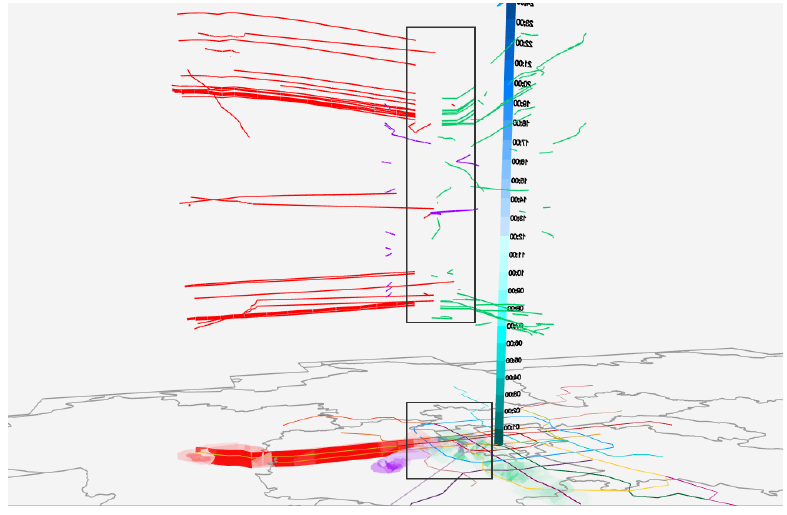
Figure 6. The intersection of passengers’ spatial-temporal trajectories.